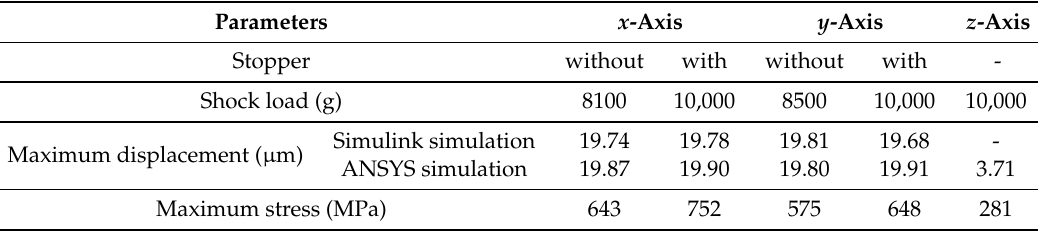
Table 4. Simulation results of the transient dynamic analysis along the x -, y - and z -axis. Parameters x -Axis y -Axis z -Axis Stopper without with without with - Shock load (g) 8100 10,000 8500 10,000 10,000 Simulink simulation Maximum displacement ( µ m) Maximum stress (MPa)